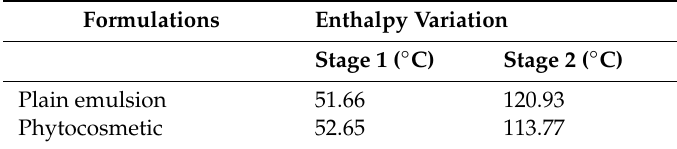
Table 3. Temperature values ( ◦ C) presented during enthalpy variation of components from plain emulsion and